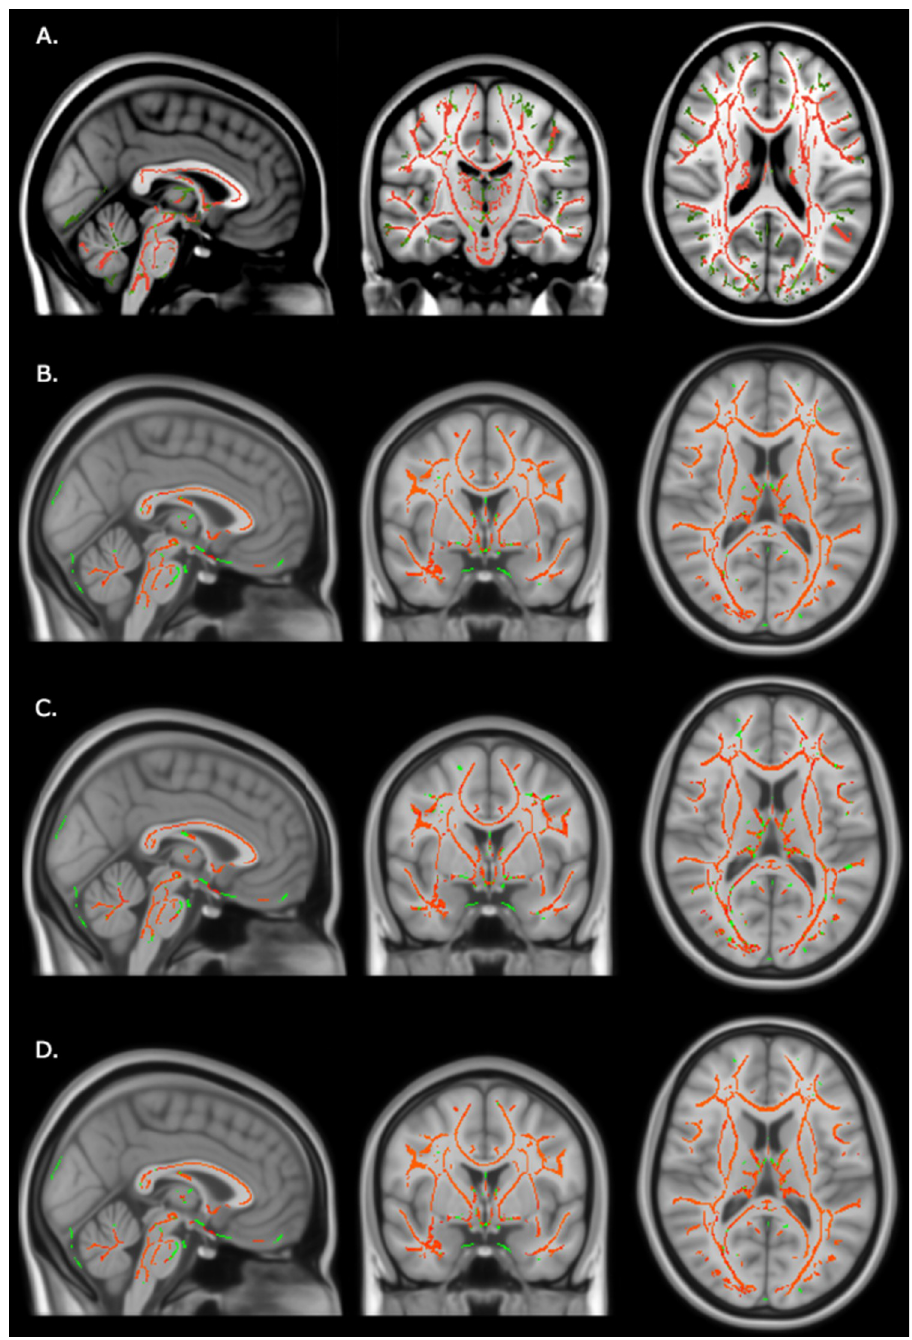
Fig 1. Red voxels denote greater fractional anisotropy (A), mean diffusivity (B), axial diffusivity (C), and radial diffusivity (D) among individuals exposed to parent-managed behavioral intervention ( n = 13) relative to individuals not exposed to parent-managed behavioral intervention ( n = 13). Green voxels indicate the mean WM skeleton of all subjects. Red and green voxels are plotted onto longitudinal, sagittal and horizontal standardized anatomical